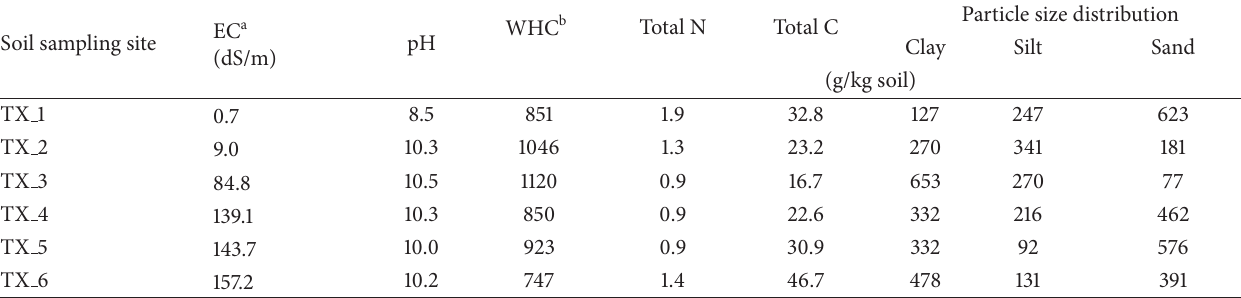
Table 1: Some physical-chemical characteristics of soils from the former lake Texcoco. WHC b Total N Total C Soil sampling site